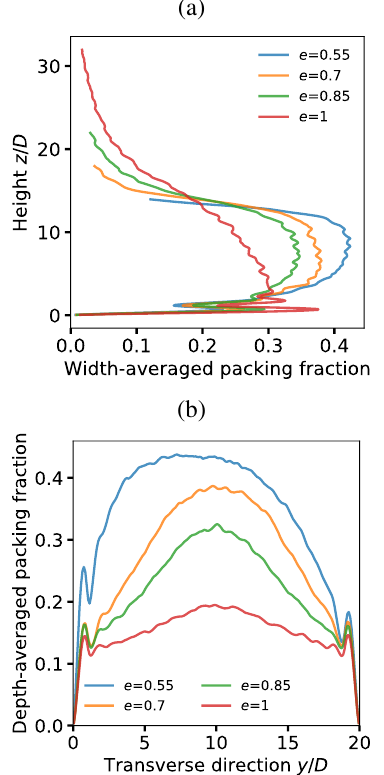
Figure 5: (a) Vertical packing fraction profiles for decreas- ing restitution coe  cient. (b) Corresponding transverse packing fraction profiles. The inclination angle is ✓ = 40  and the particle hold-up is H = 5 D